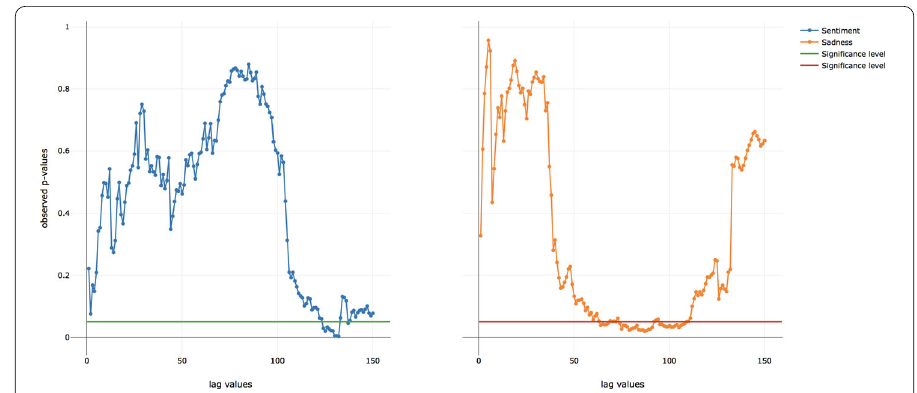
Figure 3 Bitcoin direct causality— p -values as a function of lags. Left: Bitcoin returns—sentiment time series direct causality. Right: Bitcoin returns—sadness time series direct